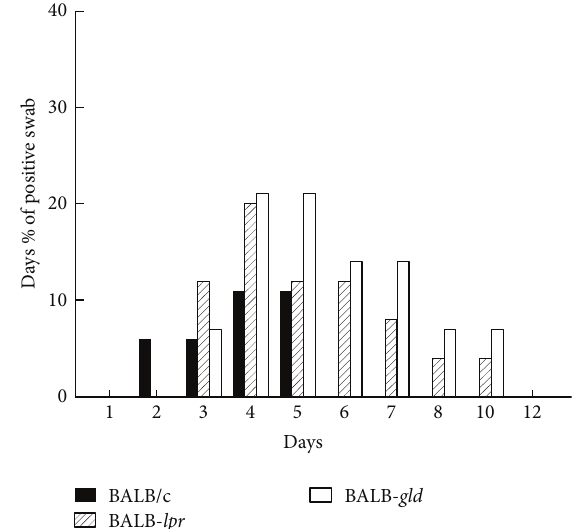
Figure 6: Daily percent of mice that were shedding virus following UV-B reactivation. Mice were reactivated by UV-B irradiation and swabbed daily and the presence of virus for each sample tested. Mice containing mutations in Fas ( lpr ) and FasL ( gld ) shed virus significantly longer than wild-type BALB/c mice ( 𝑃 < 0.01